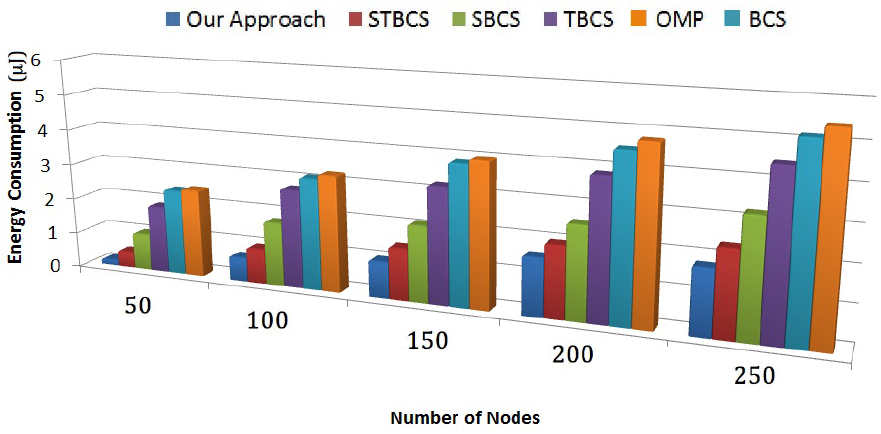
Figure 15. Energy consumption.